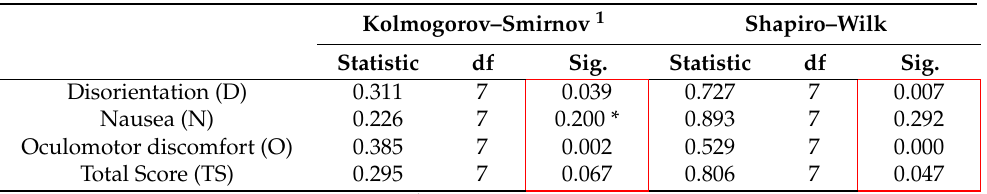
Table 17. Results of the normality test for SSQ scores for each subject: